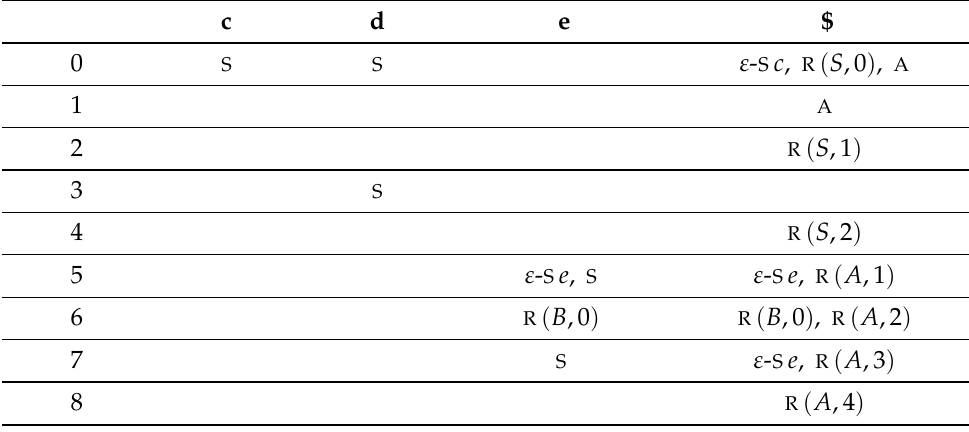
Table 3. The action table T A for the specification Ξ in (4).